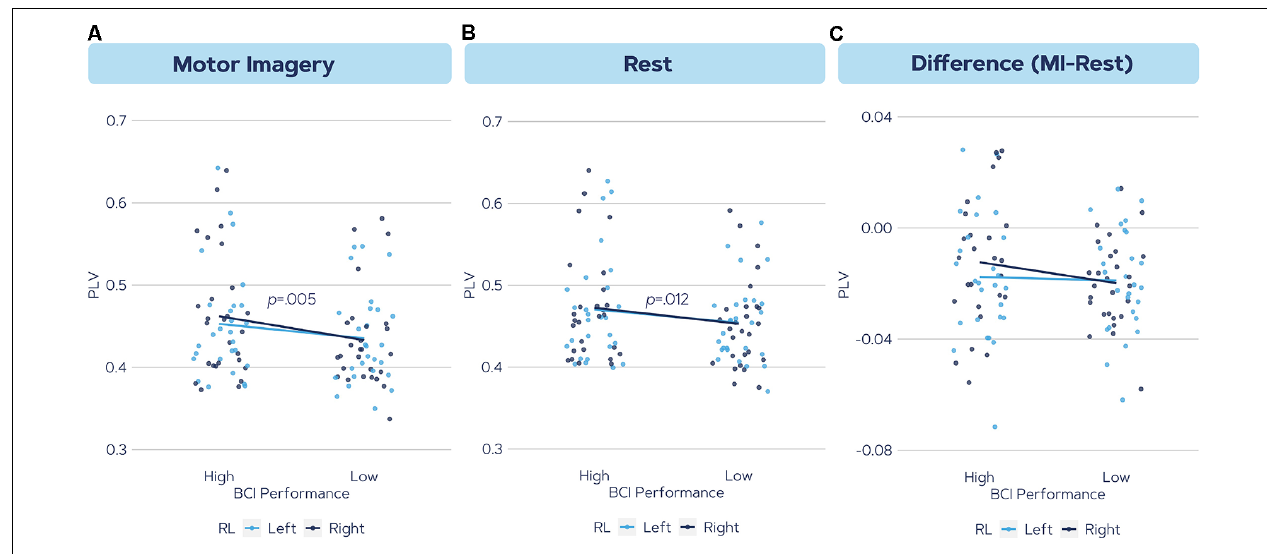
FIGURE 3 | The phase synchronization values in the alpha frequency band in the local scale right hemisphere during (A) motor imagery, (B) rest, and (C) the difference between motor imagery connectivity and rest. The color indicates left and right trials. Results indicated a significant difference in (A) and a trend in (B)